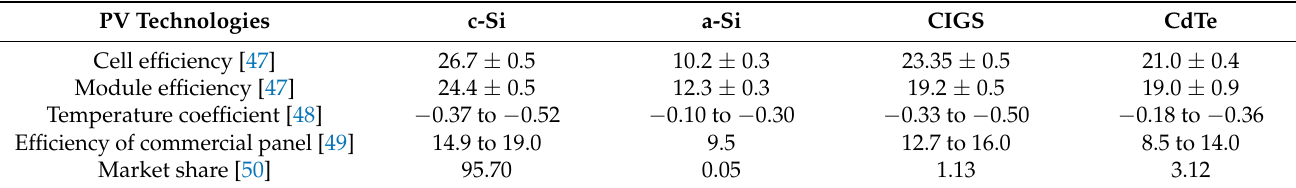
Table 1. Efficiency, temperature coefficient and market share of different PV technologies (unit: %). PV Technologies